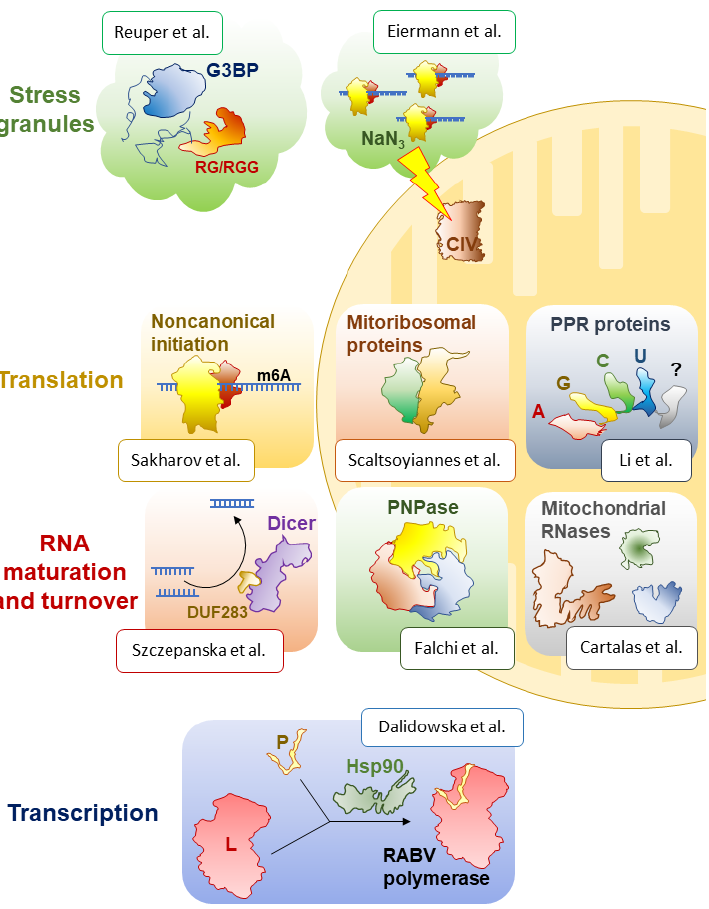
Figure 1. Overview of the contents of the Special Issue “ Research progress in RNA-binding pro- teins ”[1–9].